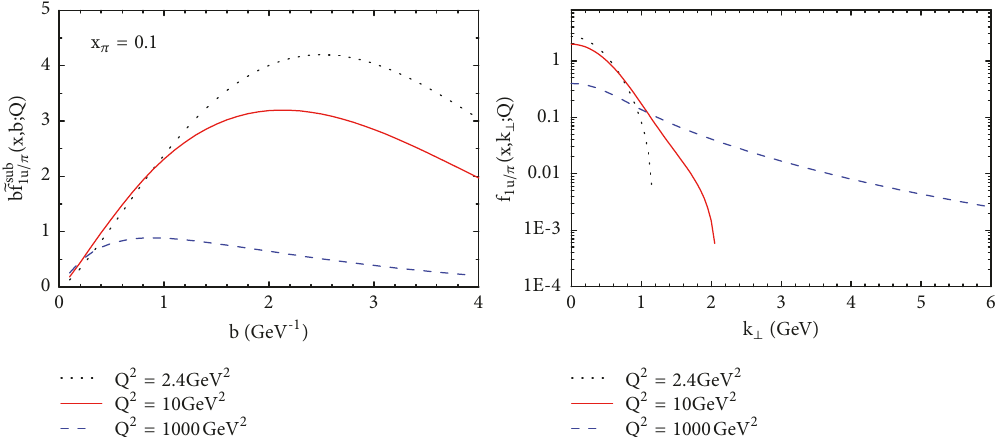
Figure 2: Subtracted unpolarized TMD distribution of the pion meson for valence quarks in 𝑏 -space (left panel) and 𝑘 ⊥ -space (right panel), at energies: 𝑄 2 = 2.4 GeV 2 (dotted lines), 𝑄 2 = 10 GeV 2 (solid lines), and 𝑄 2 = 1000 GeV 2 (dashed lines). From